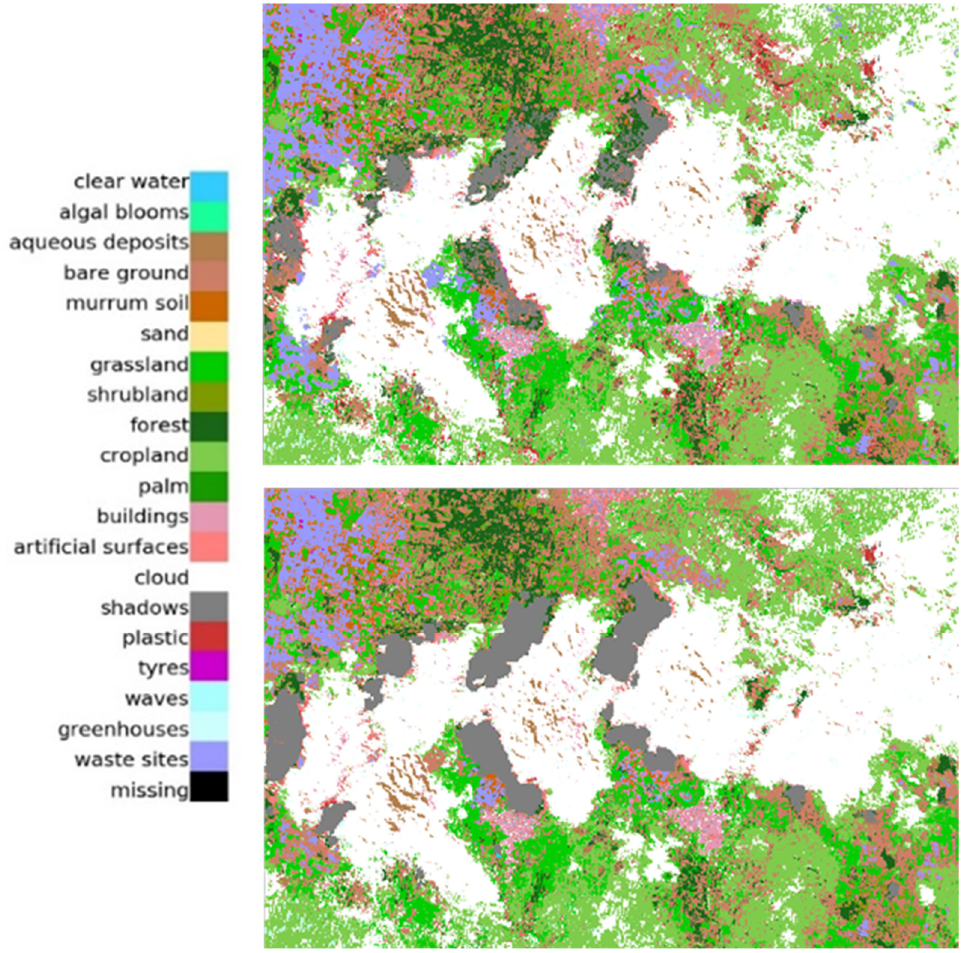
Figure 8. Comparison of the classification results before ( top ) and after ( bottom ) the post-network decision tree for the subset of the Solo River location shown in Figure 1.